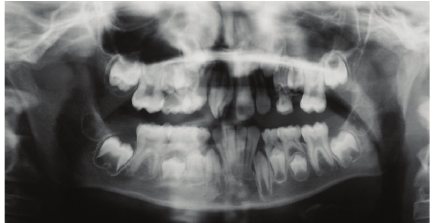
Figure 2: Panoramic radiography. Notice the fused tooth with two root